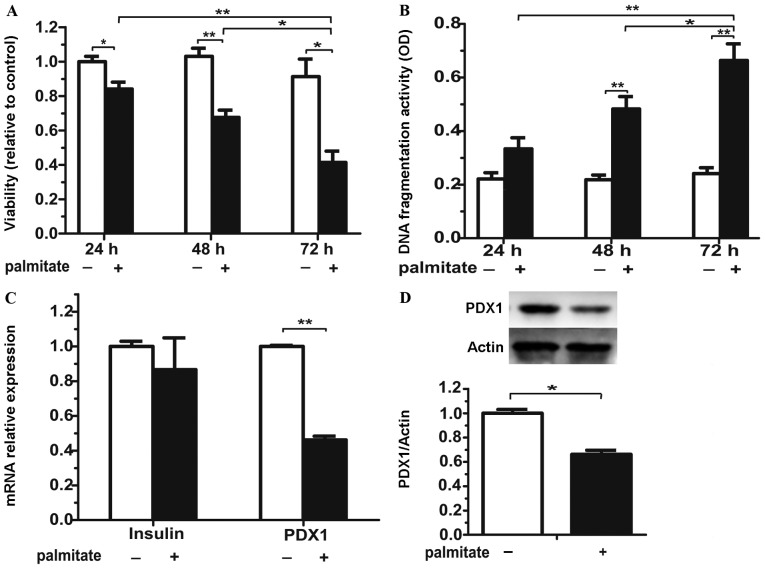
Palmitate induces injury to isolated mouse islets. Following incubation with 0.5 mmol/l palmitate for the indicated periods of time (24, 48 and 72 h), islet (A) viability and (B) apoptosis were analyzed by examining histone-associated DNA fragments and by MTT assay, respectively. Following incubation with 0.5 mmol/l palmitate for 48 h, (C) the insulin mRNA and (D) pancreatic duodenal homeobox 1 (PDX1) mRNA and protein levels were determined by qPCR and immunoblot analysis, respectively. The relative transcript levels were normalized to those of 36B4. n=3 separate islet preparations; *p<0.05; **p<0.01.